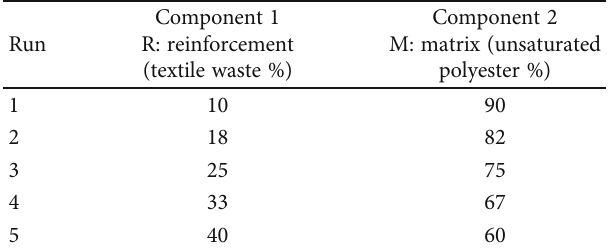
Table 1: The proportion of the mixtures using mixture optimal design of expert